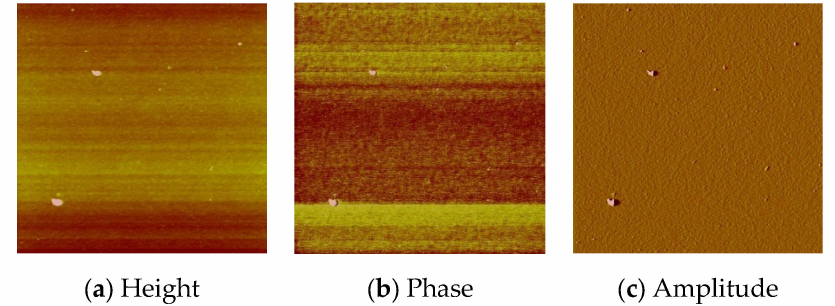
Figure 11. AFM of L2 /Si; 2500 rpm, 10s × 15, scan size 10 µ m, R a = 1.75 nm, R q = 2.22 nm. The EDS mapping confirmed the presence of the carbon, hydrogen, and oxygen on the entire silicon surface. (Figure 12— L1 /Si and Figure 13— L2 /Si).